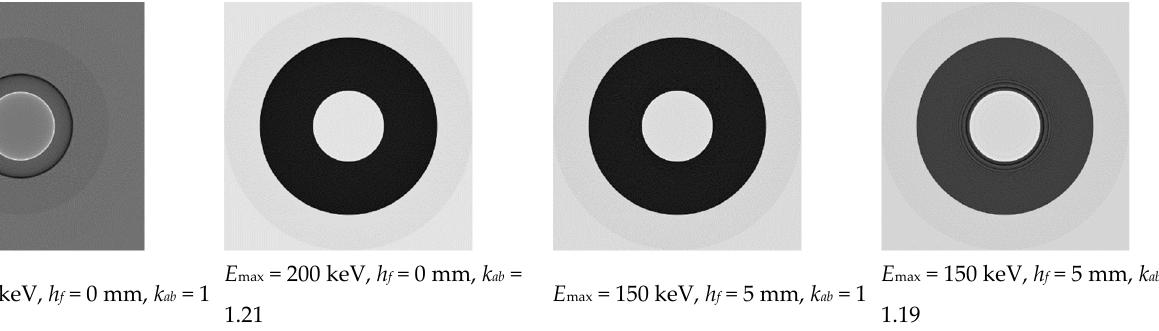
Figure 3. Reconstructed slices of an aluminum pipe with a diameter of 250 mm and a wall thickness of 75 mm, k ADC = 16.